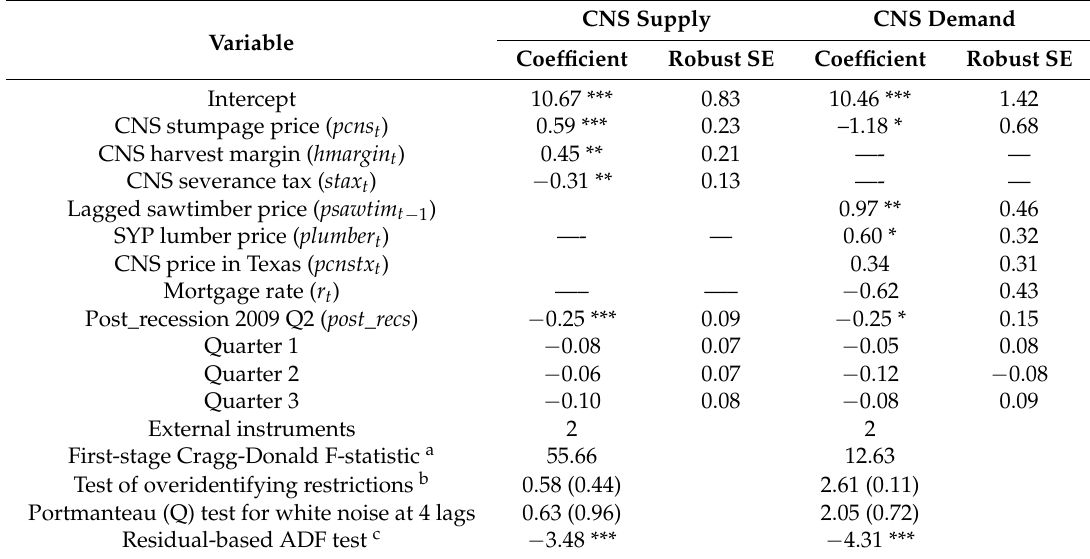
Table 3. The results of two-stage least squares regression of the chip and saw (CNS) stumpage market in Louisiana: 2003 Q1–2016